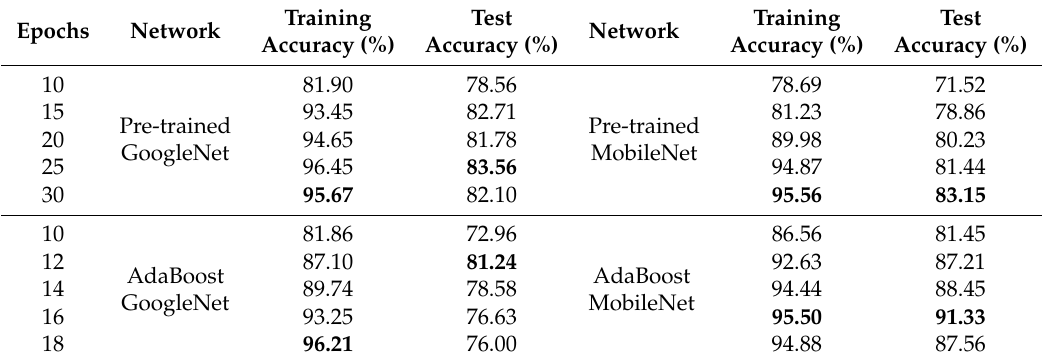
Table 6. A comparison of training and test accuracy of transfer learned and AdaBoost-optimised Google and MobileNets.